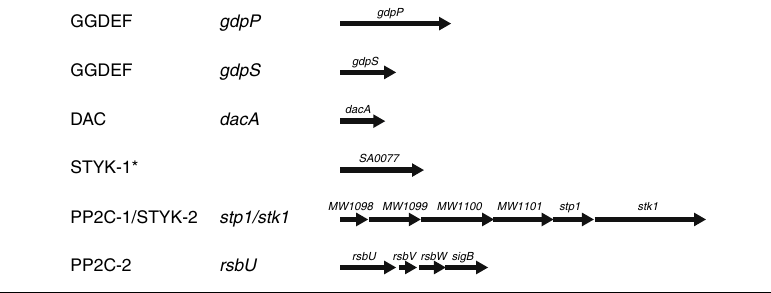
Fig. 1 Signal transduction systems present in S. aureus . a Representation of the S. aureus genome with the 17 operons encoding two-component systems 14 (http://www.ncbi.nlm.nih.gov/Complete_Genomes/SignalCensus.html). Histidine kinases are colored magenta, response regulators are colored green, and accessory genes are colored blue. Note that TCS-2 is only present in certain strains that carry a particular SCCmec element. b Additional signal transduction systems in S. aureus 14 (http://www.ncbi.nlm.nih.gov/Complete_Genomes/SignalCensus.html). Genes and operons encoding the corresponding involved proteins in each signal transduction system are represented and colored